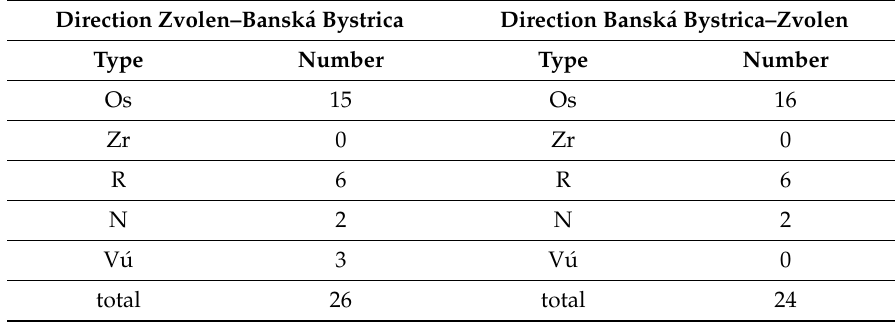
Table 2. Number and types of trains during the measurement of ZV2.